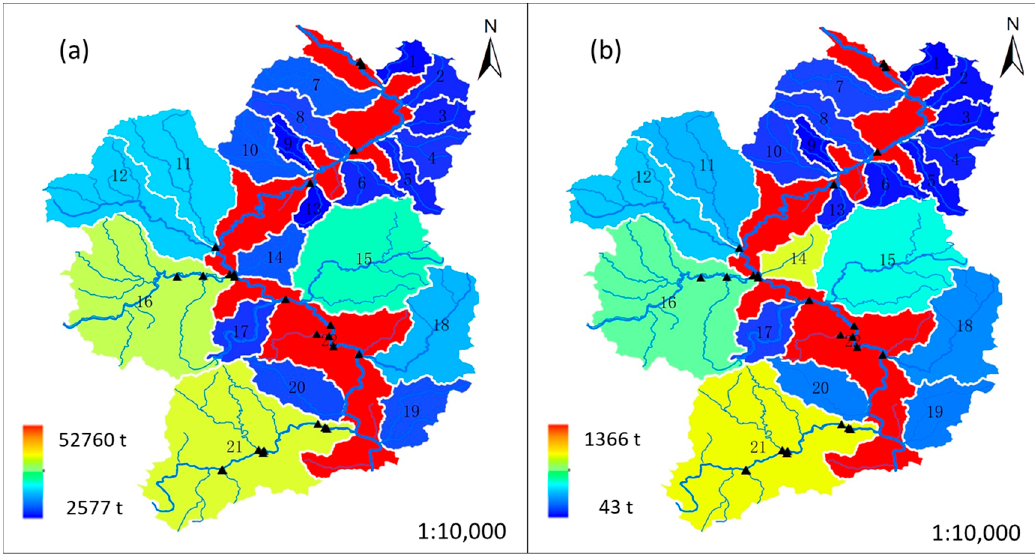
Figure 7. Spatial distribution of pollutant load in 2015. ( a ) Chemical oxygen demand; ( b ) ammonia